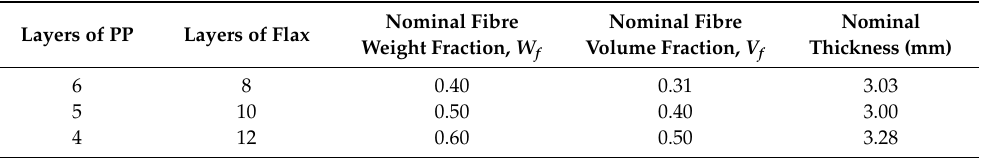
Table 1. Number of layers of PP and flax fabric, nominal fibre weight fractions, fibre volume fractions, and thicknesses of composite